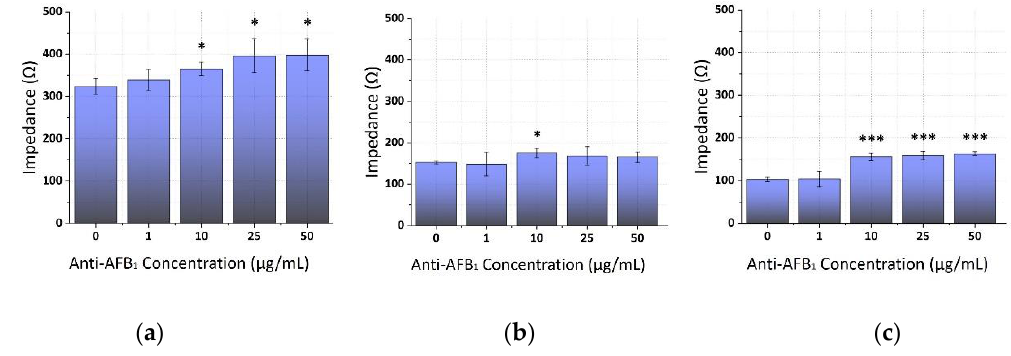
Figure 3. Extracted results from the mean impedance magnitude values for different concentrations of immobilized anti-AFB 1 tested with 5 ng/mL AFB 1 at three frequencies ± STD: ( a ) 1 KHz, ( b ) 10 KHz and ( c ) 100 KHz. Two-tailed t-test, p * < 0.05, p *** < 0.001 significantly different from the control.